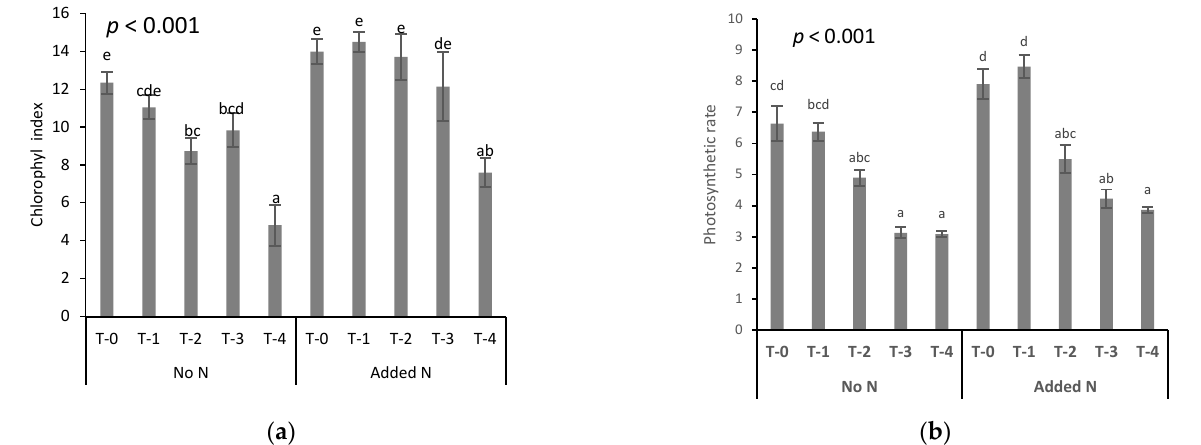
Figure 2. ( a ) Chlorophyll index; ( b ) Photosynthetic rate (μmol CO 2 m −2 s −1 ). Different letters denote statistically significant differences at p < 0.05. Error bars represent standard error (T-1 = 25, T-2 = 50, T-3 = 100, T-4 = 150 mg Cr(VI) kg −1 soil).